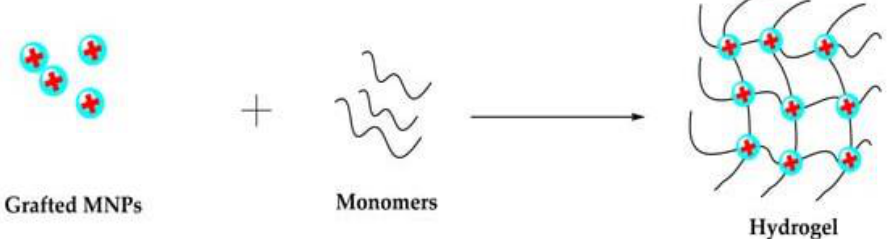
Figure 7. Schematic representation of grafting method. Reprinted with permission from ref. [50], MDPI, 2022.